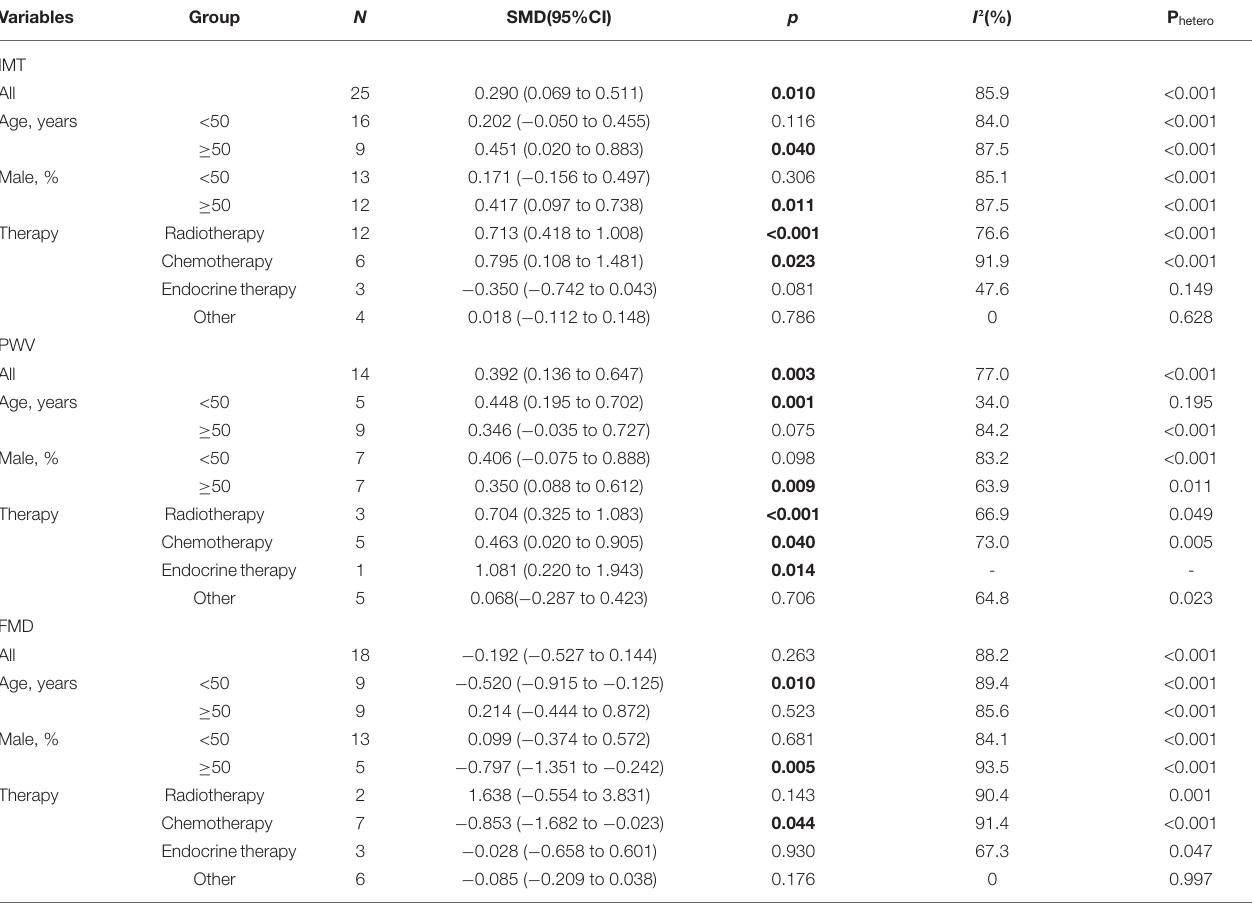
TABLE 1 | IMT, PWV, and FMD between patients with cancer and controls without cancer in overall and sub-group meta-analyses by age and female ratio. Variables Group